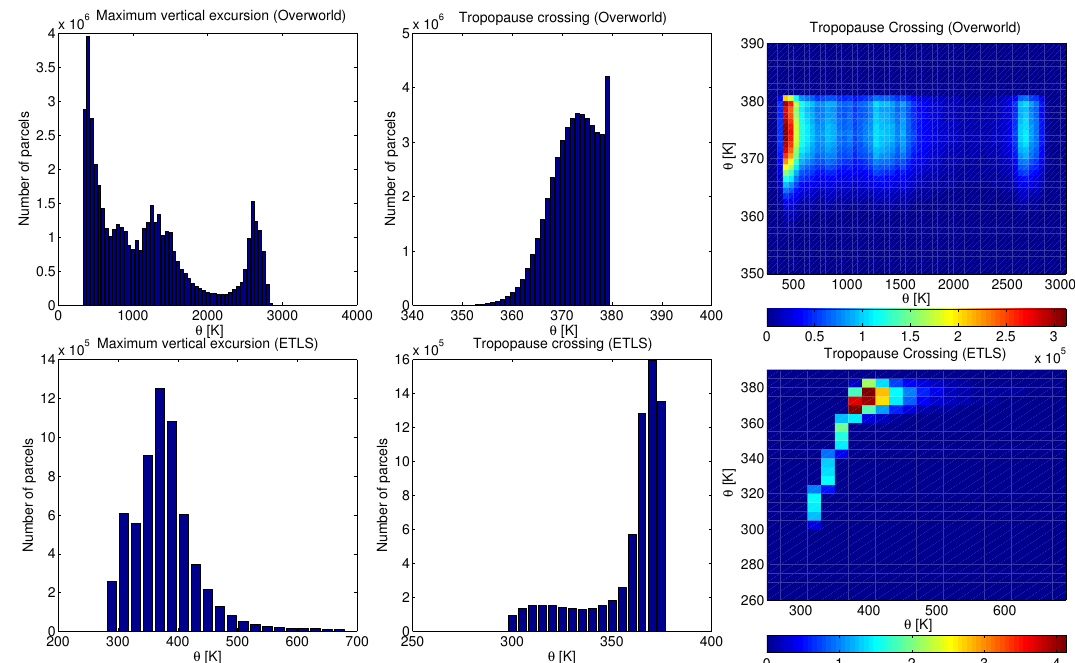
Fig. 4. Potential temperature distribution of maximum vertical excursion (left) and altitude of tropopause crossings (center) for the populations of particles launched in the extratropical lowermost stratosphere (bottom) and in the overworld (top). The vertical separation is made at the pressure level 113 hPa (level 26 of the ECMWF grid). The right panels show the joined histograms of vertical excursions and tropopause crossings. In the bottom panels the particles with vertical excursion larger than 700 K (6 % of the total) are not shown. The histograms are calculated over 22 yr and over the ensemble of particles which were located in the stratosphere at day 1 of the backward trajectory.